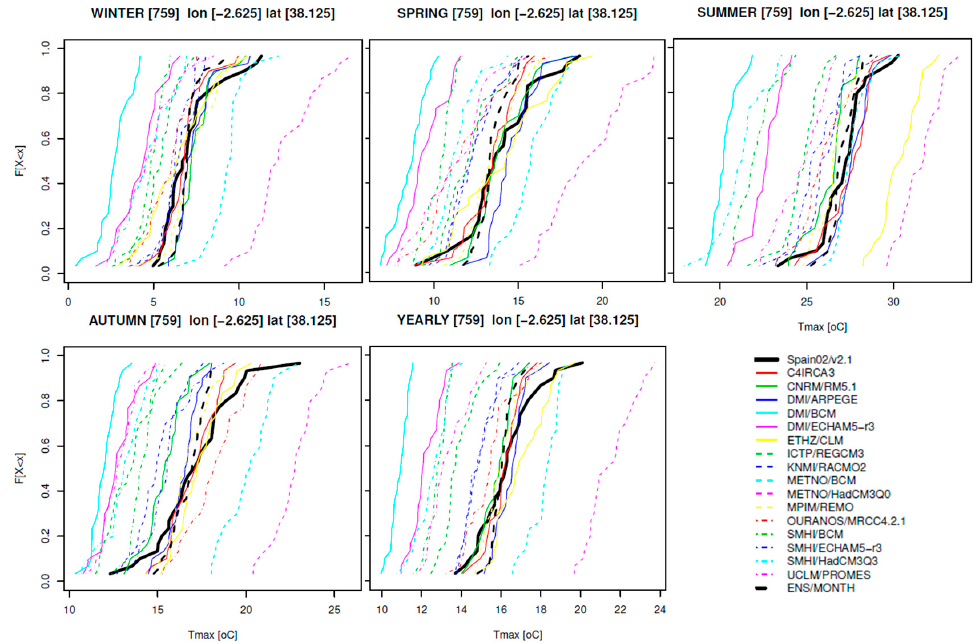
Figure 6. Seasonal and yearly maximum temperature CDFs on site 759, located in the Fuensanta Basin, from observational dataset (in black), RCMs (in color) and RCM ensembles (black dashed black) for the 1961–1990 period.